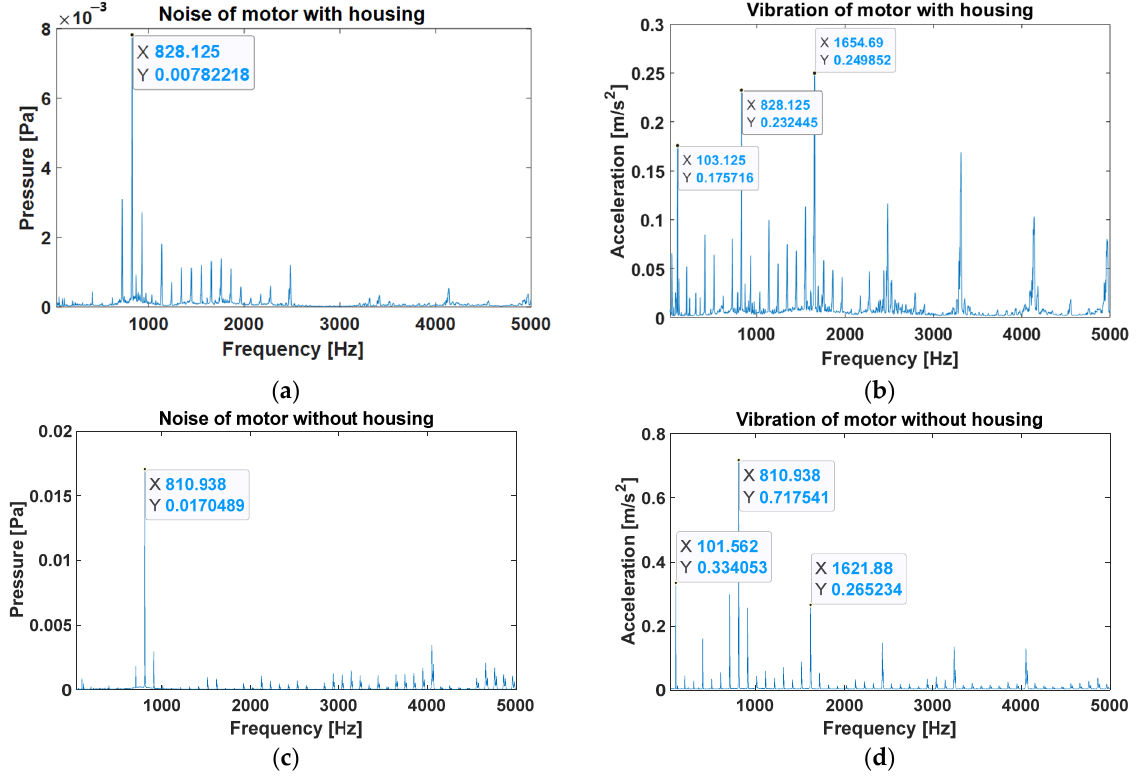
Figure 5. FFT results of noise and vibration of the sample motor. The values measured by the microphone and accelerometer were acquired as raw data in SQUADRIGA II, and FFT was performed in MATLAB: ( a ) Noise experiment results including motor housing; ( b ) vibration experiment results including motor housing; ( c ) noise experiment result with motor housing removed; ( d ) vibration experiment result with motor housing removed.